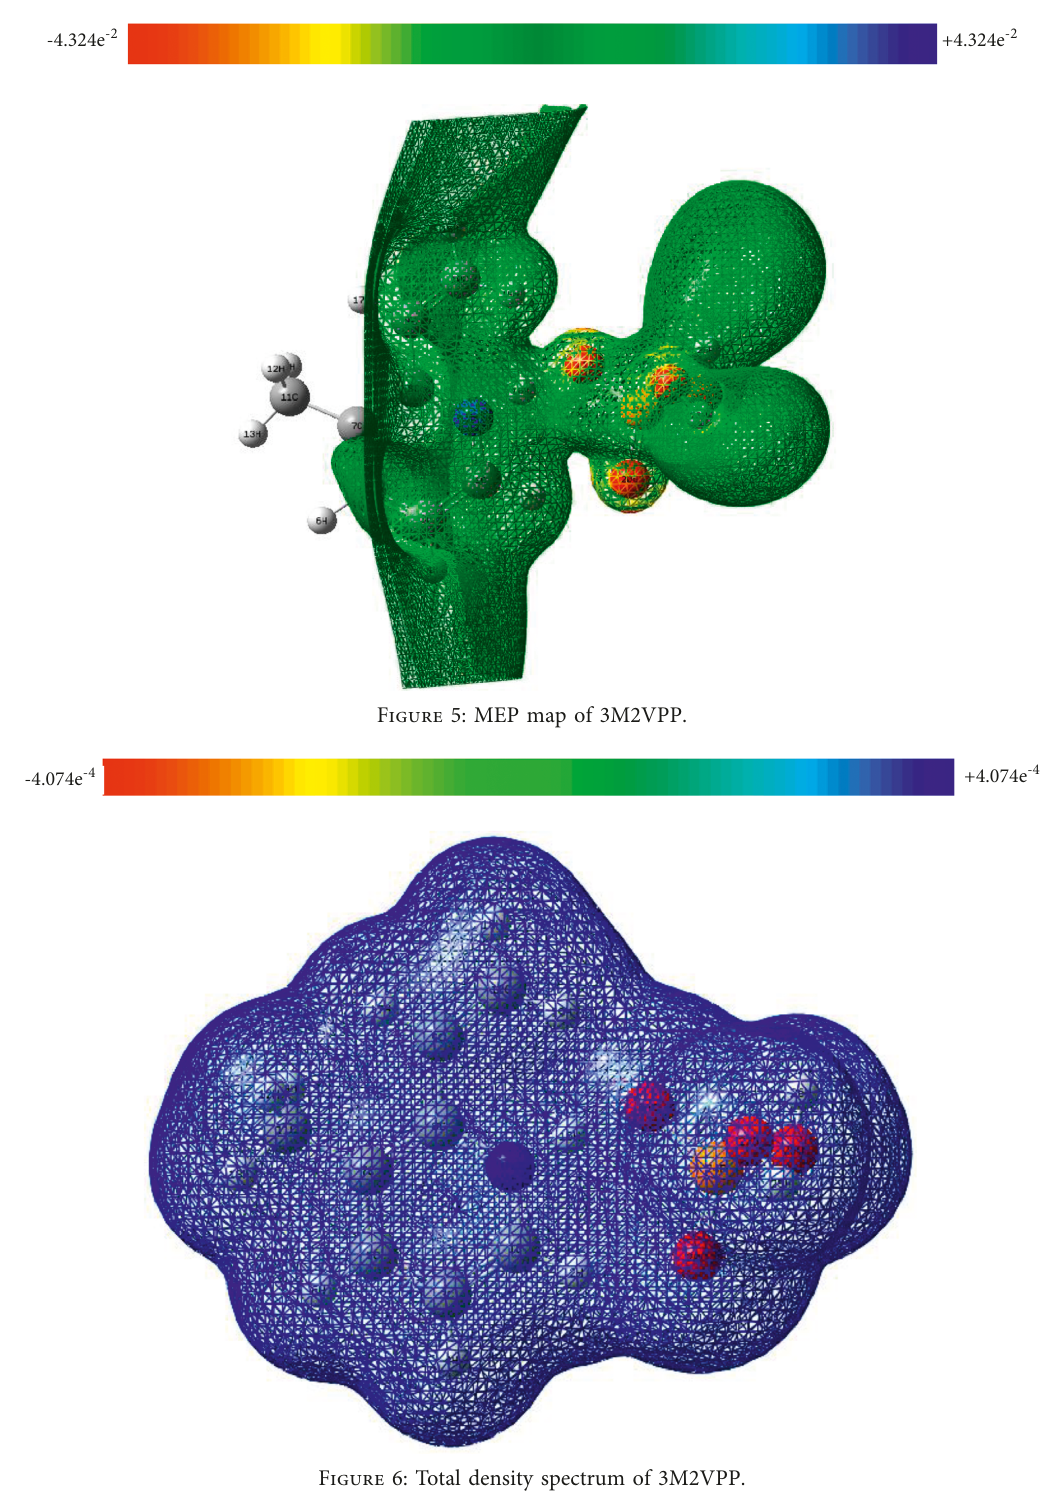
Figure 6: Total density spectrum of 3M2VPP.